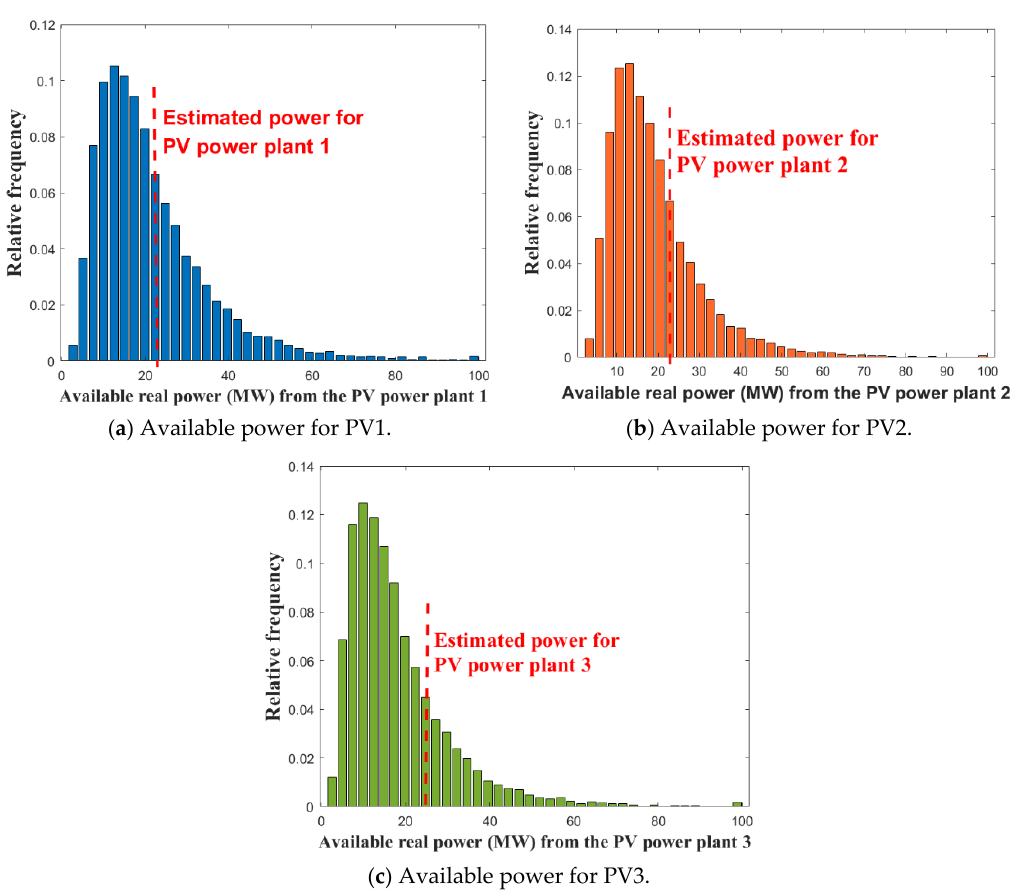
Figure 5. Available power of the three PV power plants.